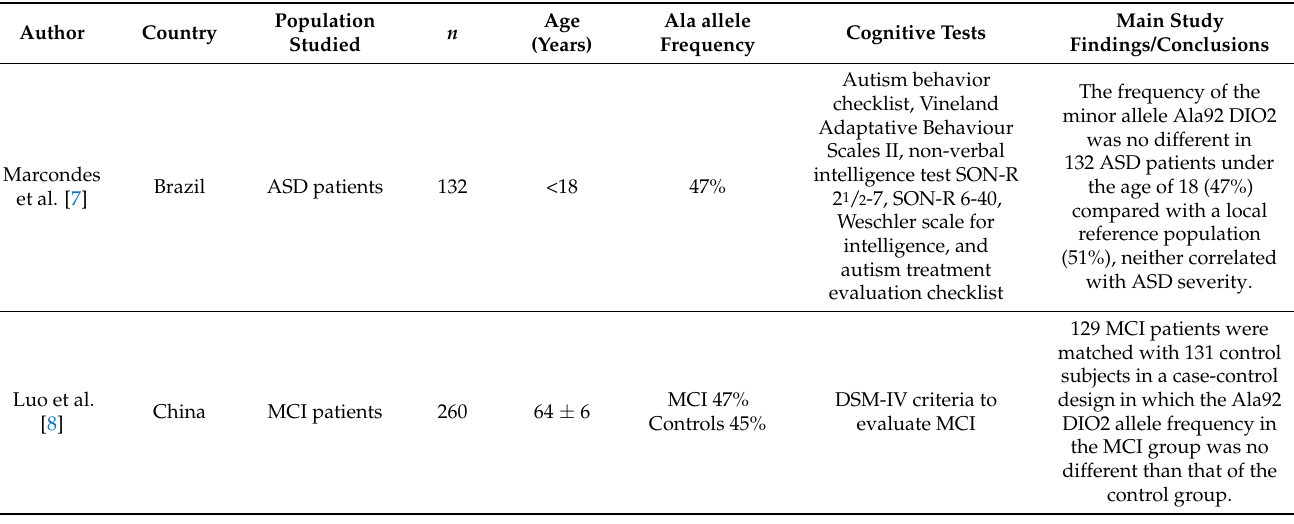
Table 2. Summary of the previous studies analyzing the association of the Thr92Ala DIO2 polymor- phism and